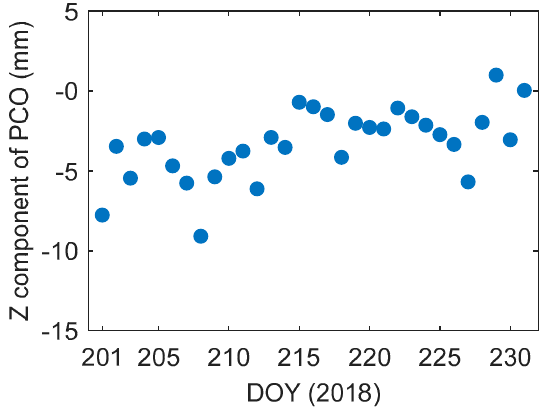
Figure 7. Estimated Z component phase center offset (PCO) for CSES’ onboard positioning antenna in the antenna reference frame (ARF).